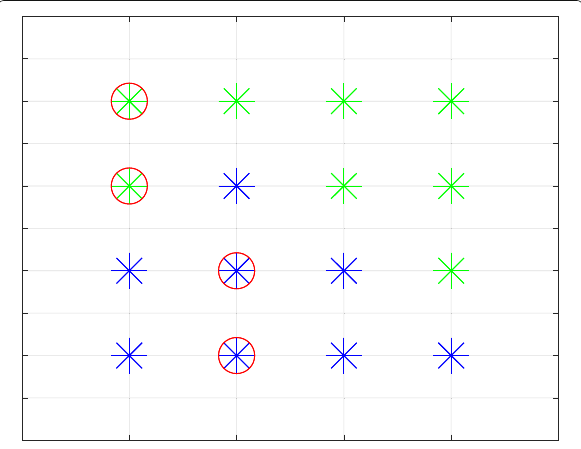
Fig. 15 The grouping result of the proposed dynamic geo-based resource selection algorithm (DGRSA) when jam areas are area 1, 2, 7, and 8. There are 16 stars representing our 16 geographic areas. And the stars around with red circles are the jam areas. After performing the proposed dynamic grouping method, two geographic area groups are distinguished with different colors in the